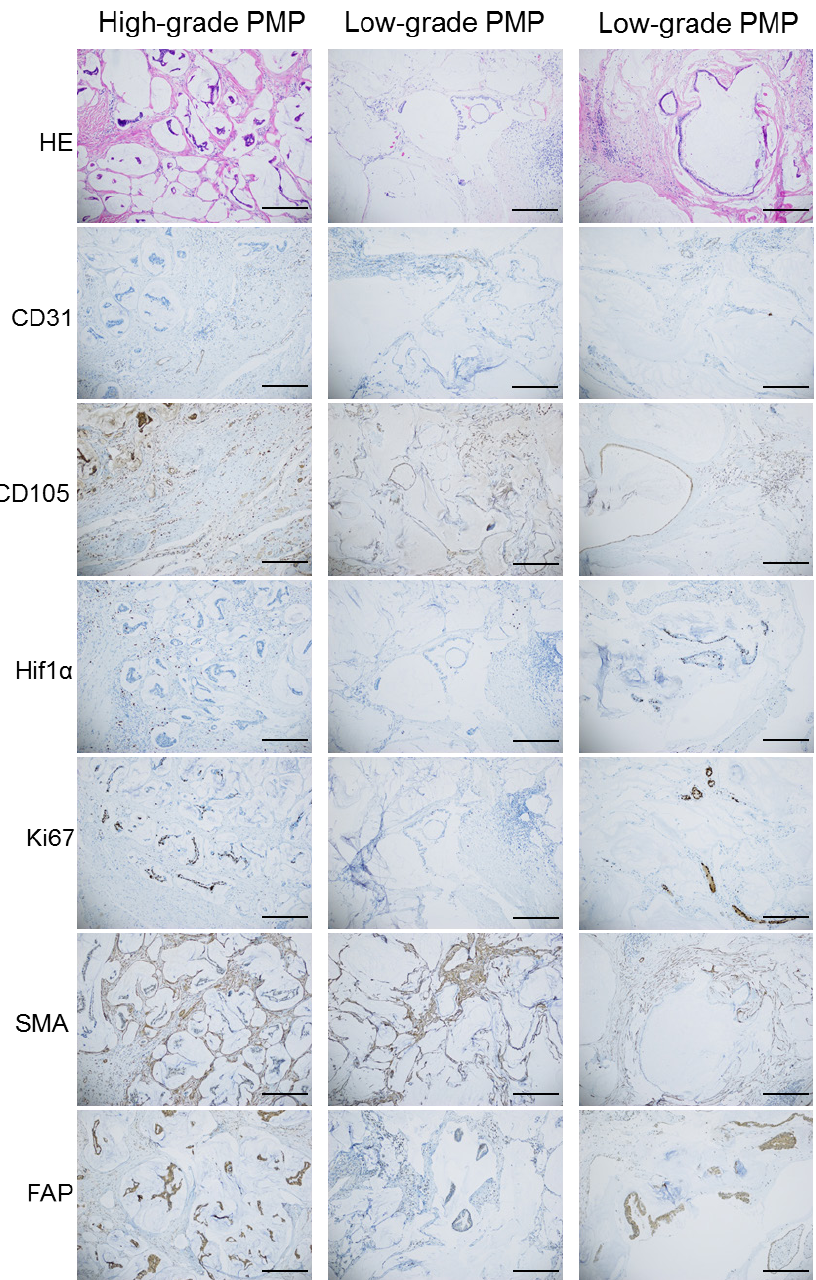
Figure 1. Representative HE and immunohistochemical images showing CD31, CD105, Hif1α, Ki67, SMA and FAP staining in samples from one patient with high-grade PMP and two with low-grade PMP. Scale bar indicates 300 µM.